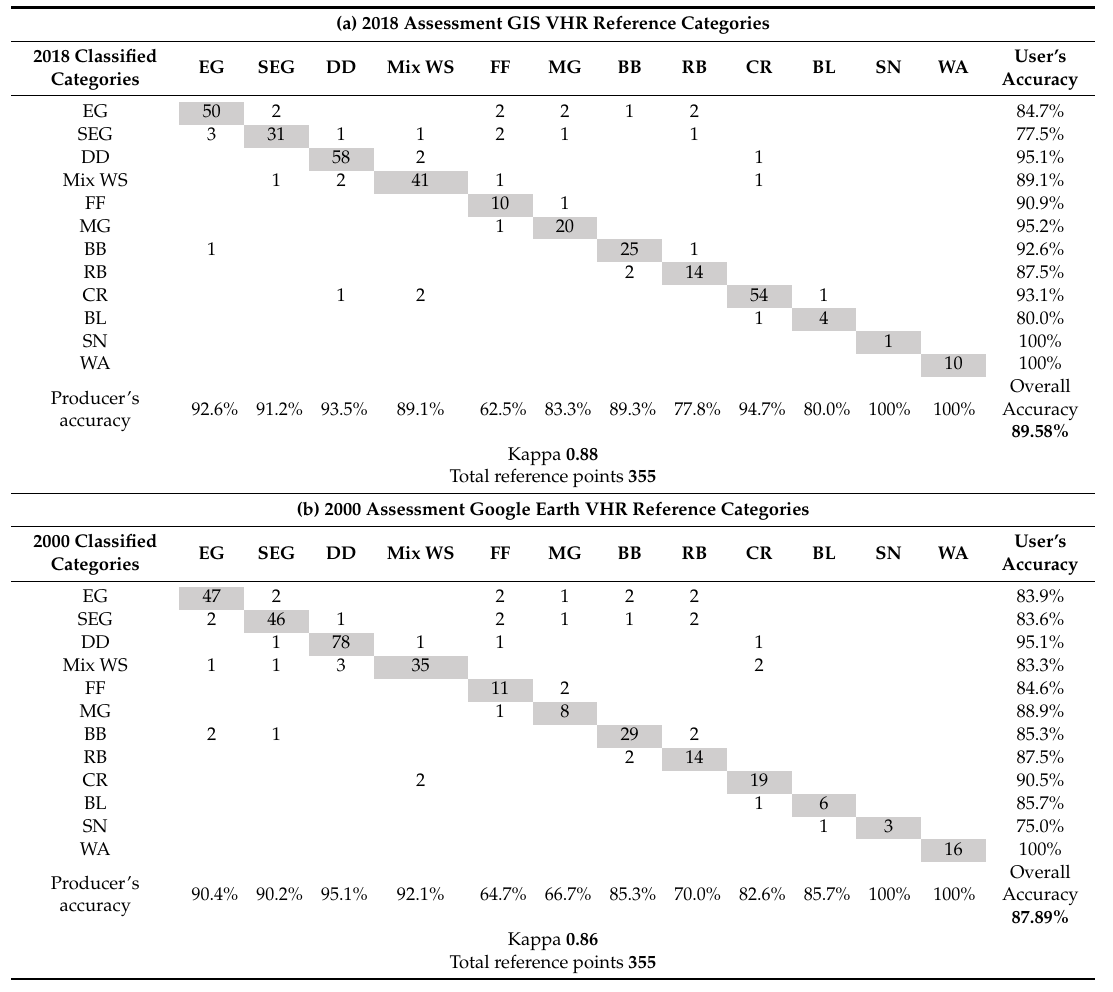
Table 3. Results of the accuracy assessment for the TM 2000 and OLI 2018 classified maps. The values of the 12 land cover categories were derived using the final accuracy matrix of the generalized map. The gray cells indicate agreement of the accuracy